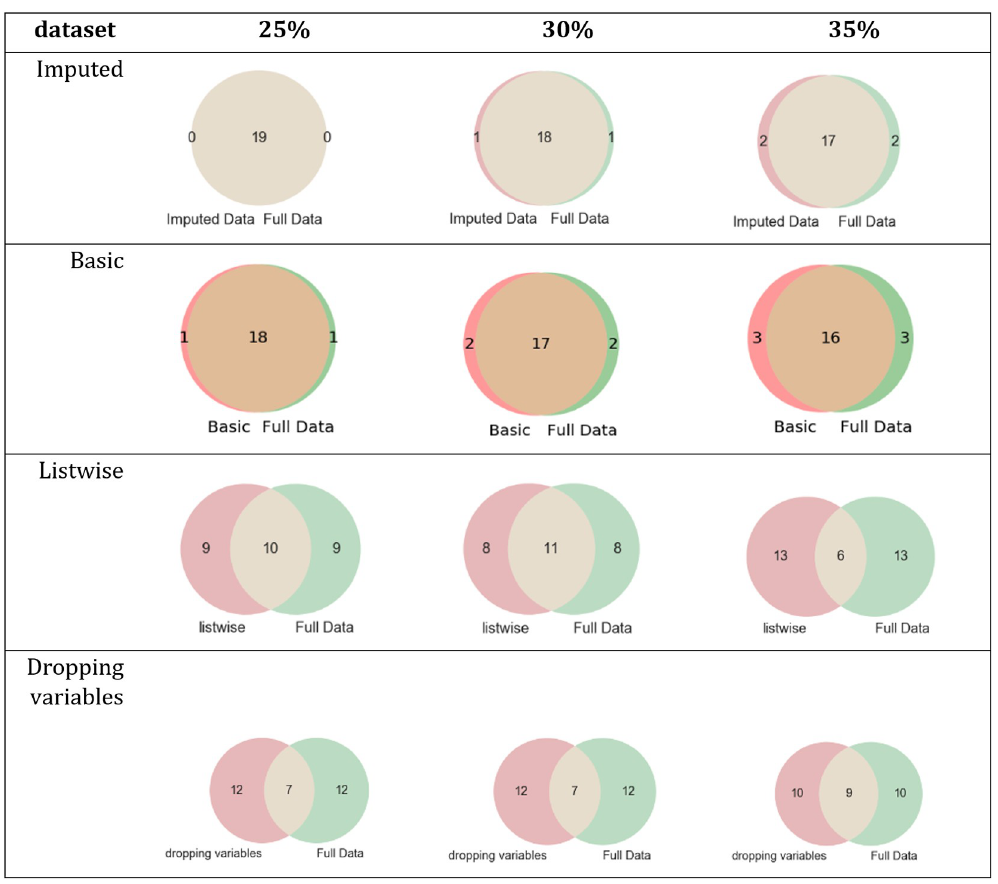
Fig 11. Intersections of sets of relevant features of the breast-cancer dataset and its simulated datasets.